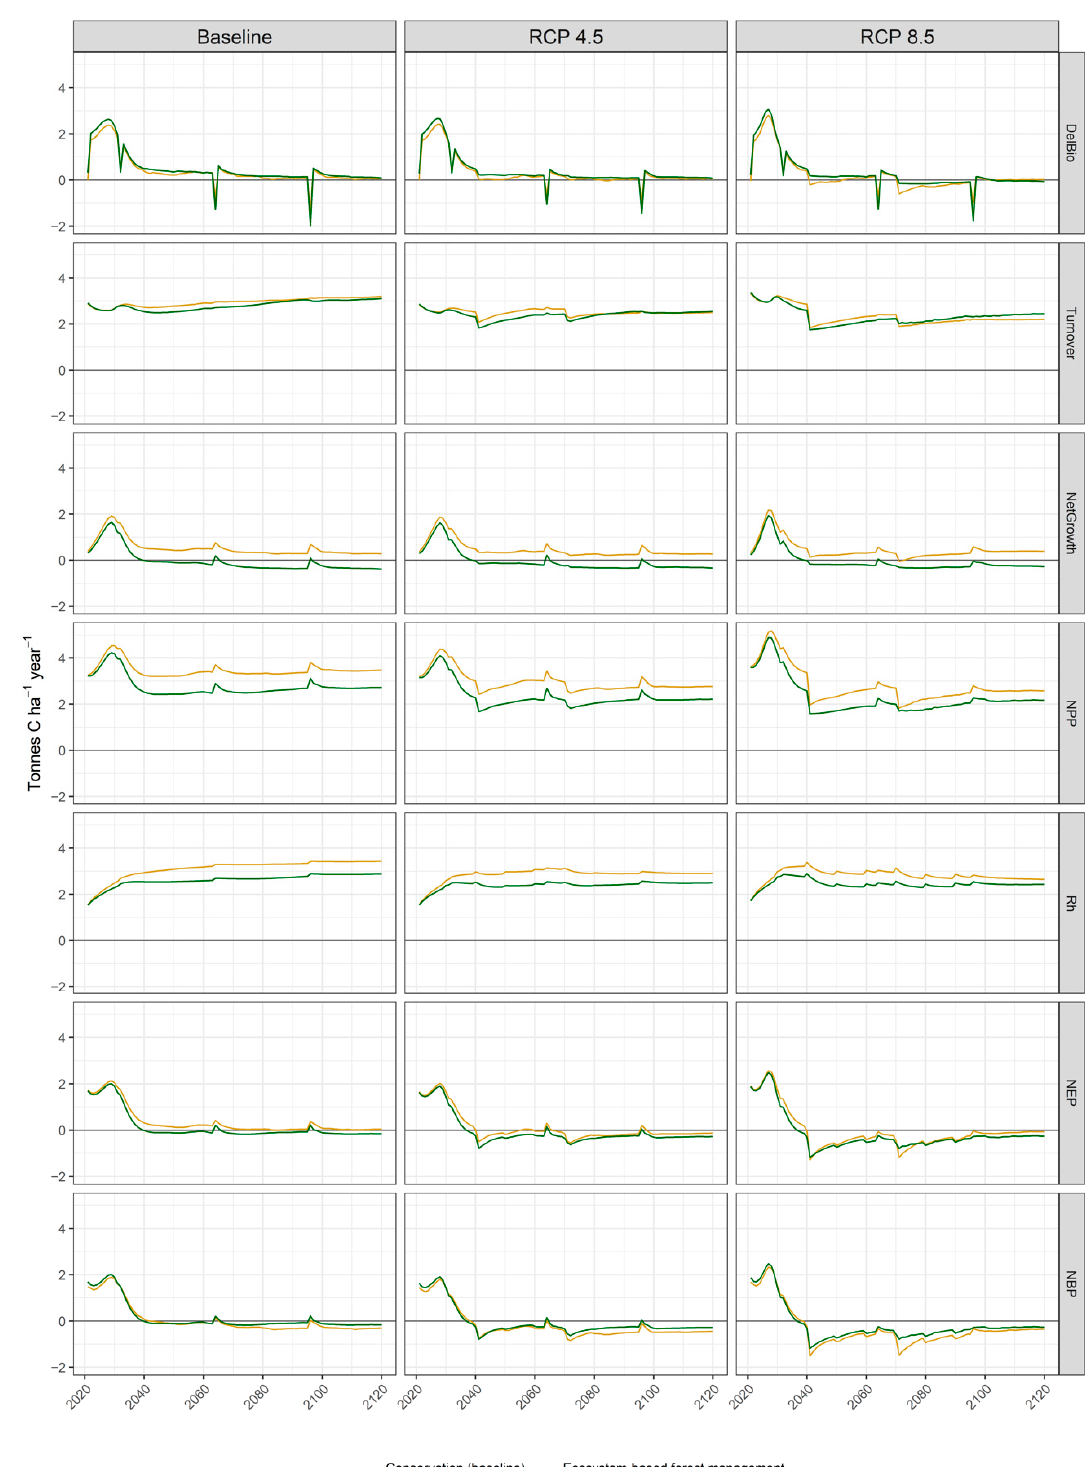
Figure 5. Ecosystem carbon fluxes of Maskinongé forests. Columns correspond to climate scenarios. Results are based on the average of five replicates. DelBio: Annual change in biomass stocks. Turnover: Annual transfer of biomass to dead organic matter and soil pools before disturbances occur. NetGrowth: Change in biomass from growth alone. NPP: Net Primary Production (=NetGrowth + Turnover). Rh: Heterotrophic respiration. NEP: Net Ecosystem Productivity (=NPP − Rh). NBP: Net Biome Productivity (=NEP − losses due to disturbances).